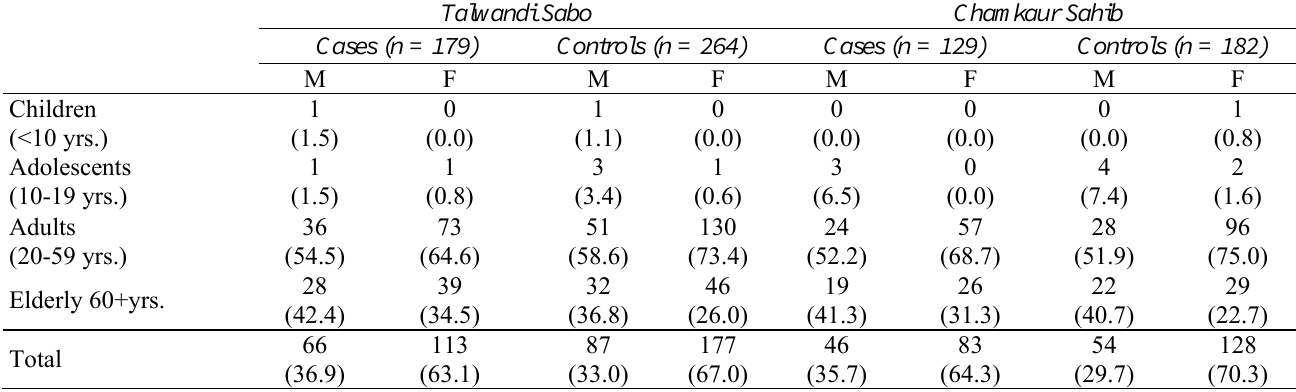
Table 3: Age and sex distribution of cases and control in study and reference